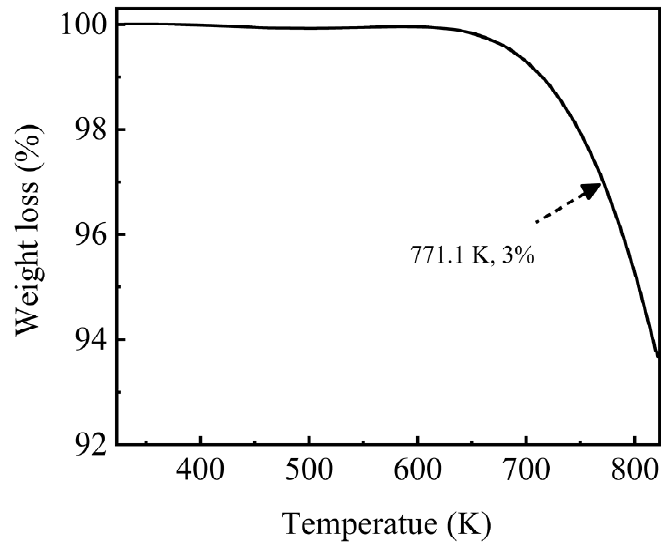
Figure 7. Weight loss of the NaNO 3 -KNO 3 -Ca(NO 3 ) 2 (16:48:36 wt%) ternary eutectic salt by TGA under Ar atmosphere from 323 K to 823 K.